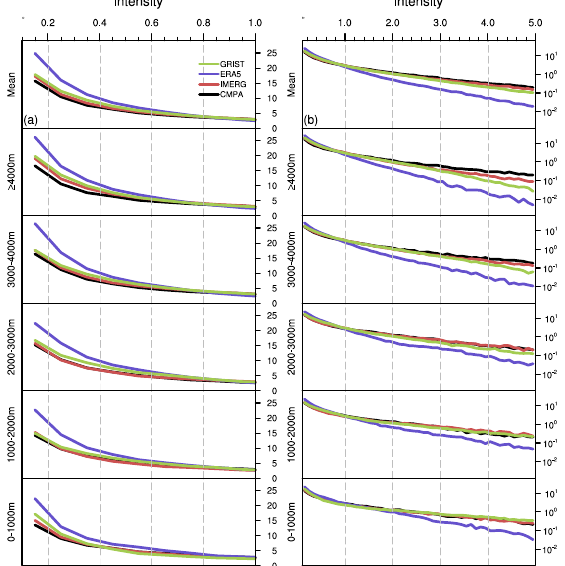
Figure 11. Elevation dependence of frequency–intensity structure in EPTP. ( a ) precipitation frequency distribution for weak intensities (0.1–1 mm/h); ( b ) precipitation frequency distribution for all in- tensities (0.1–5 mm/h) with logarithmic coordinates. Horizontal solid black lines separate different altitude blocks. The altitude of each block increases from bottom to top, with the mean frequency– intensity structure of EPTP displayed in the block at the top. The labels on the right Y -axis represent the frequency (%). The labels on the left Y -axis indicate the altitude intervals represented by each subgraph. The X -axis indicated different rainfall intensities (mm/h). Black stands in for the CMPA dataset, red for IMERG, violet for ERA5, and green for